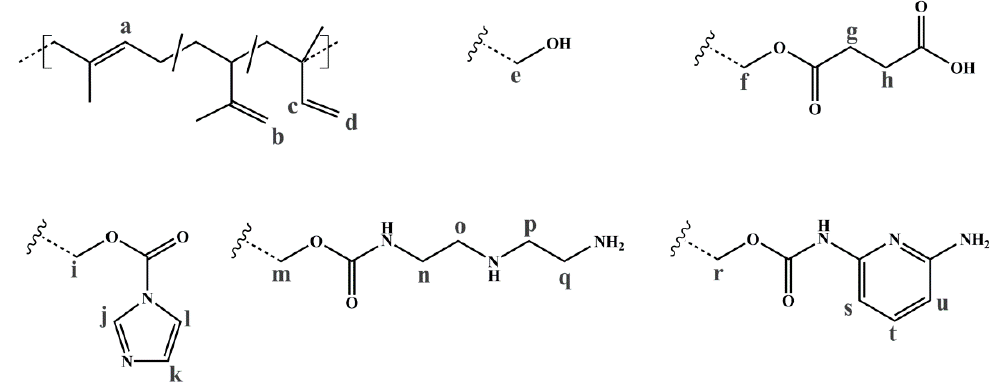
Figure 6. Used indices of the 1 H NMR related protons, corresponding to each motif. The indices are directly inserted into the 1 H NMR spectra in Figures 7 and 8.